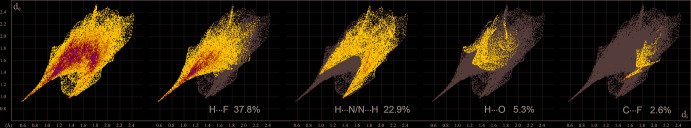
Two-dimensional fingerprint plots for the cations of the title compound, and delineated into the principal contributions of H⋯F, H⋯N/N⋯H, H⋯O and C⋯F contacts. Other important contacts are H⋯H (18.5%), H⋯C/C⋯H (3.4%) and N⋯N (3.0%).